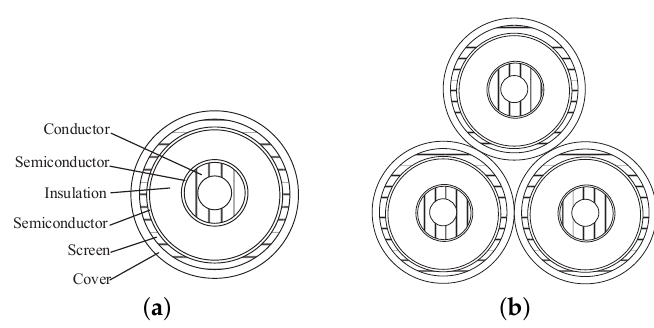
Figure 4. The configuration of MV cables modeled in PSCAD/EMTDC: ( a ) single-core (SC) cable model; and ( b ) TC cable